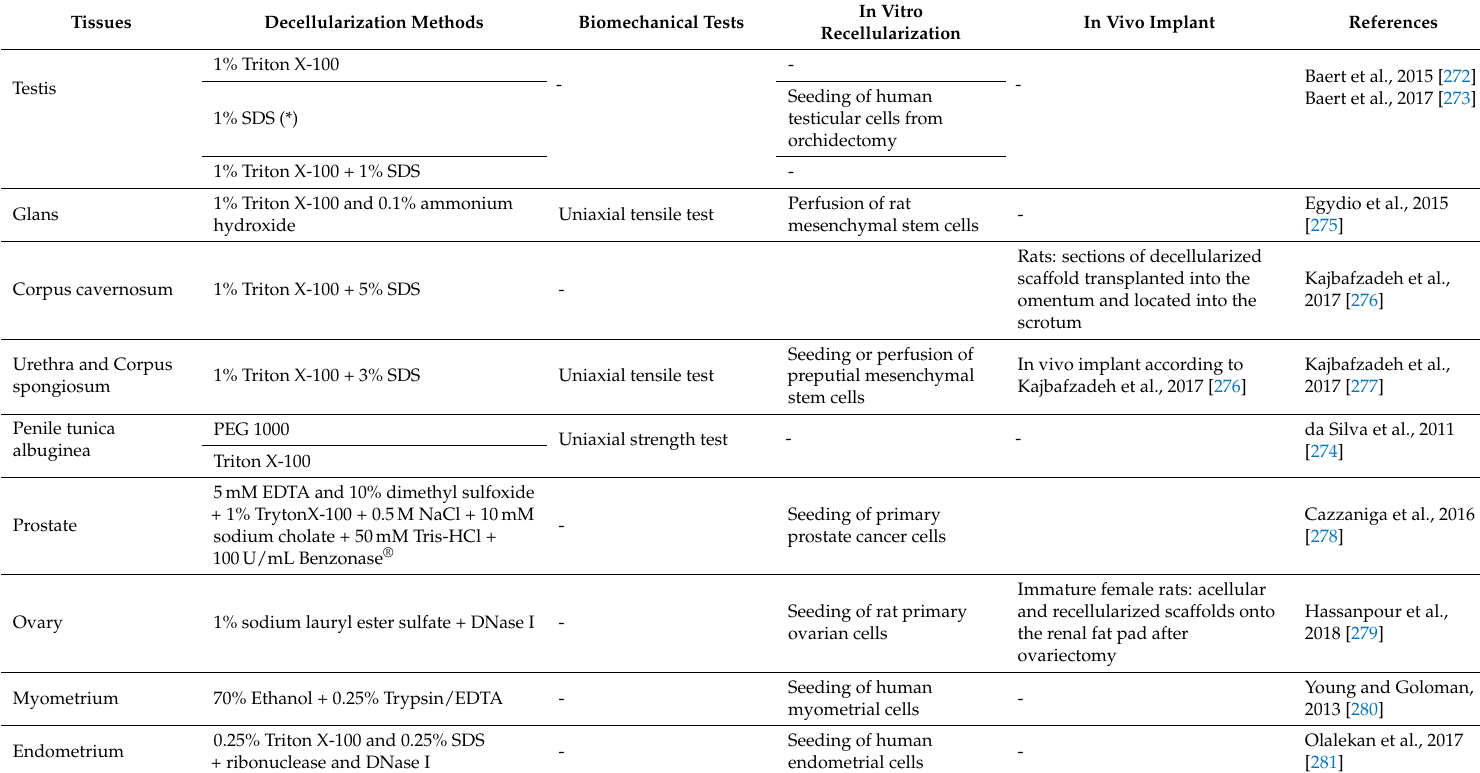
PEG, polyethylene glycol; SDS, sodium dodecyl sulfate; + means that separate cycles were performed; ‘and’ means that a mixture was performed between different substances; (*) best